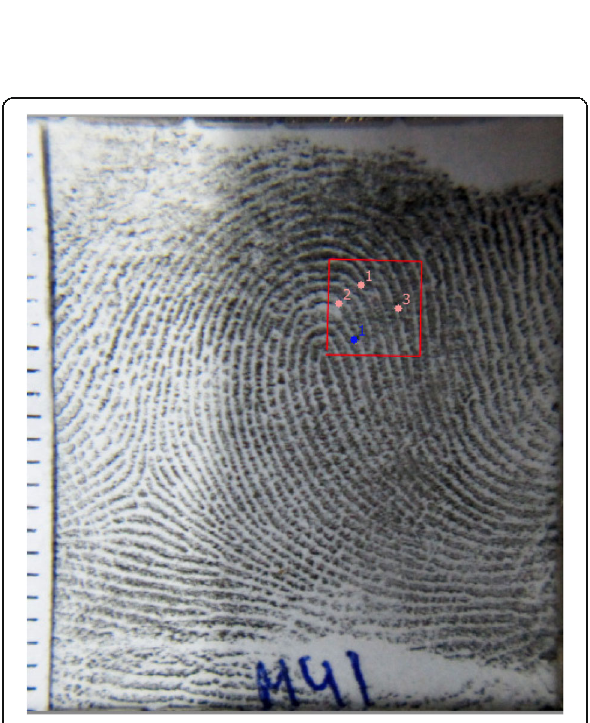
Fig. 4 Showing print of Middle finger of male Subject and 3 bifurcation marked pink colour with one ridge ending in blue colour with the help of count tool in Adobe Photoshop